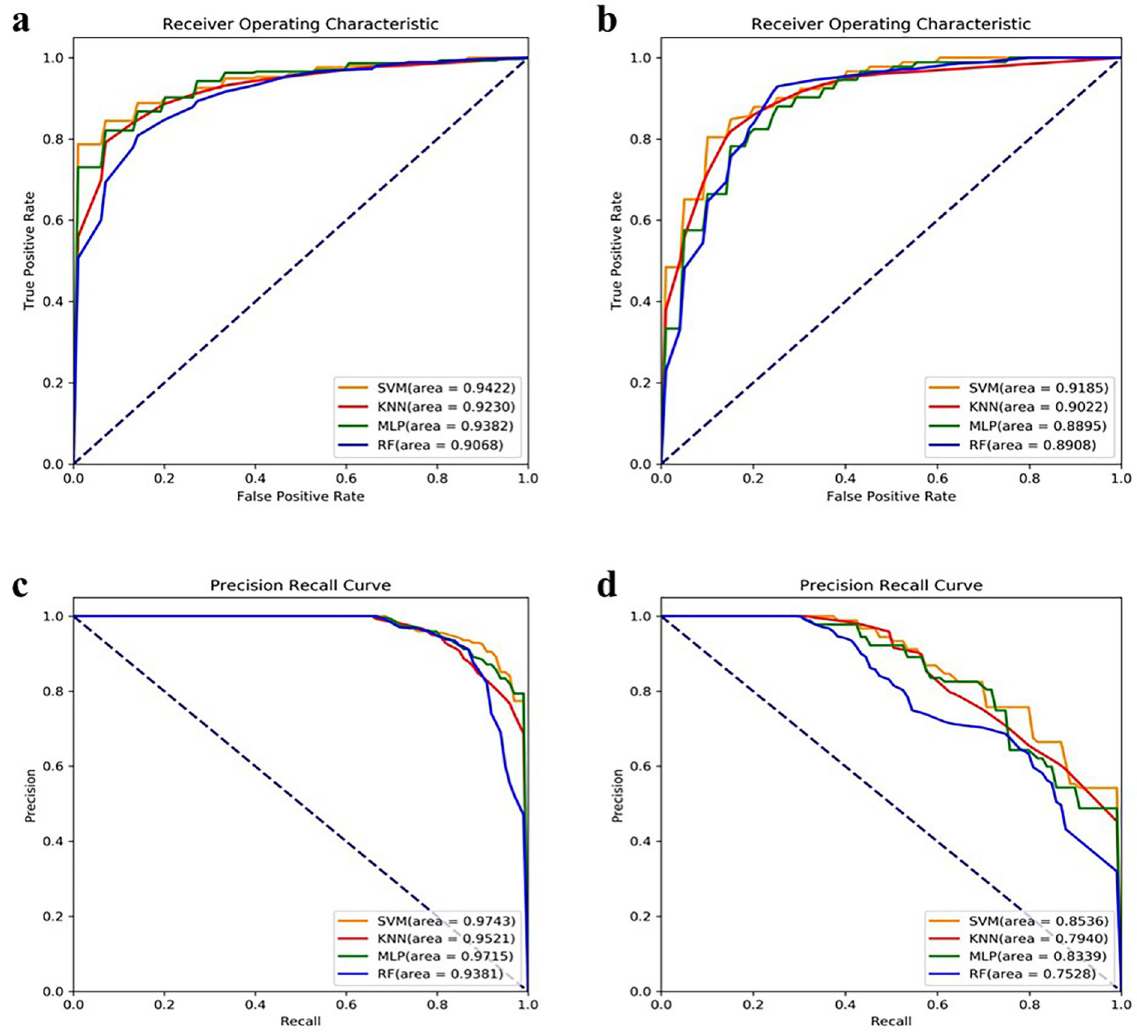
Fig 6. Comparison of ROC and PRC curve of different classifiers. (a, b) correspond to the ROC curve of dataset 1 and dataset 2. The numbers in parentheses indicate the AUROC value. The x-axis represents sensitivity, or true positive rate (TPR). The y-axis is 1-Specificity, or false positive rate (FPR). (c, d) represents the PRC curve of dataset 1 and dataset 2. The numbers in parentheses indicate the AUPRC value. The x-axis represents recall. The y-axis is